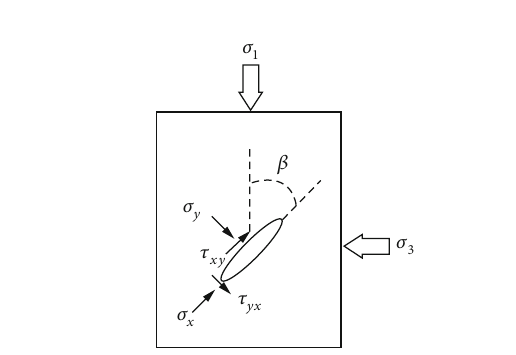
Figure 13: Schematic of a single